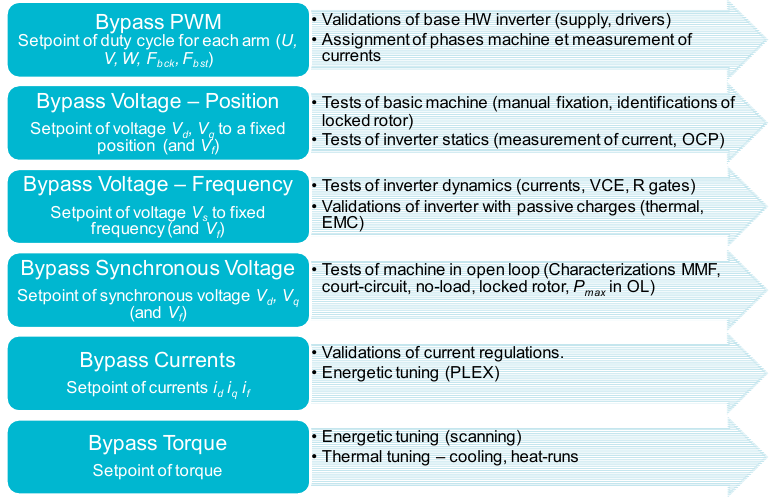
Figure 3. Definition of control modes on the platform.